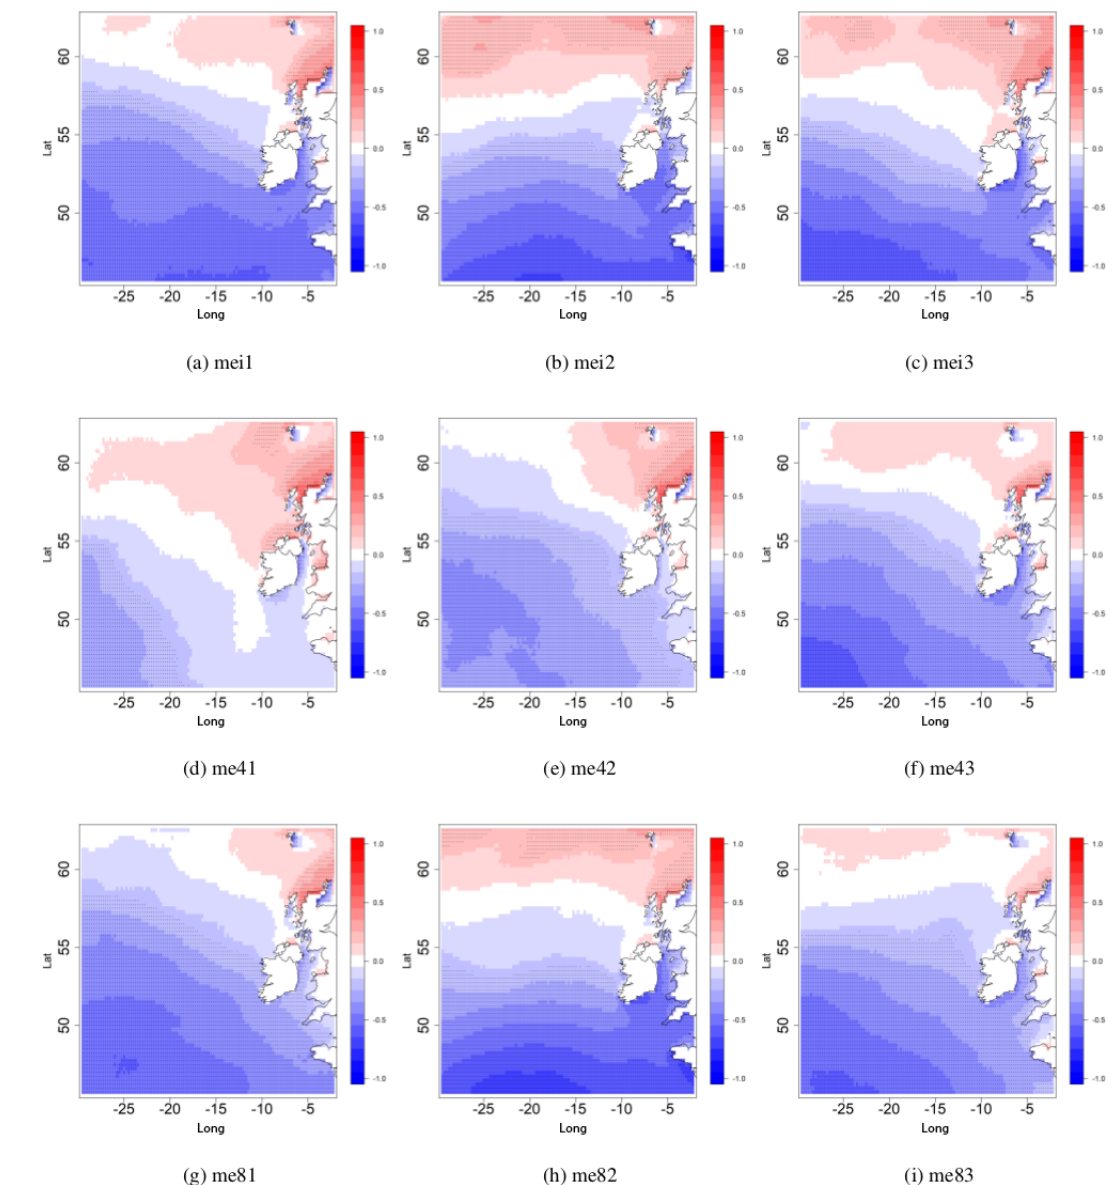
Figure 3. The Spearman correlation coefficient between the EA index and the 95th percentile of H s for DJFM. (a–c) historical period (1980–2009) 3 × ensemble members; (d–f) future period 2070–2099 under RCP4.5 and similarly (g–h) is for 2070–2099 under RCP8.5. Correlations statistically significant at the α < 0 . 05 level are